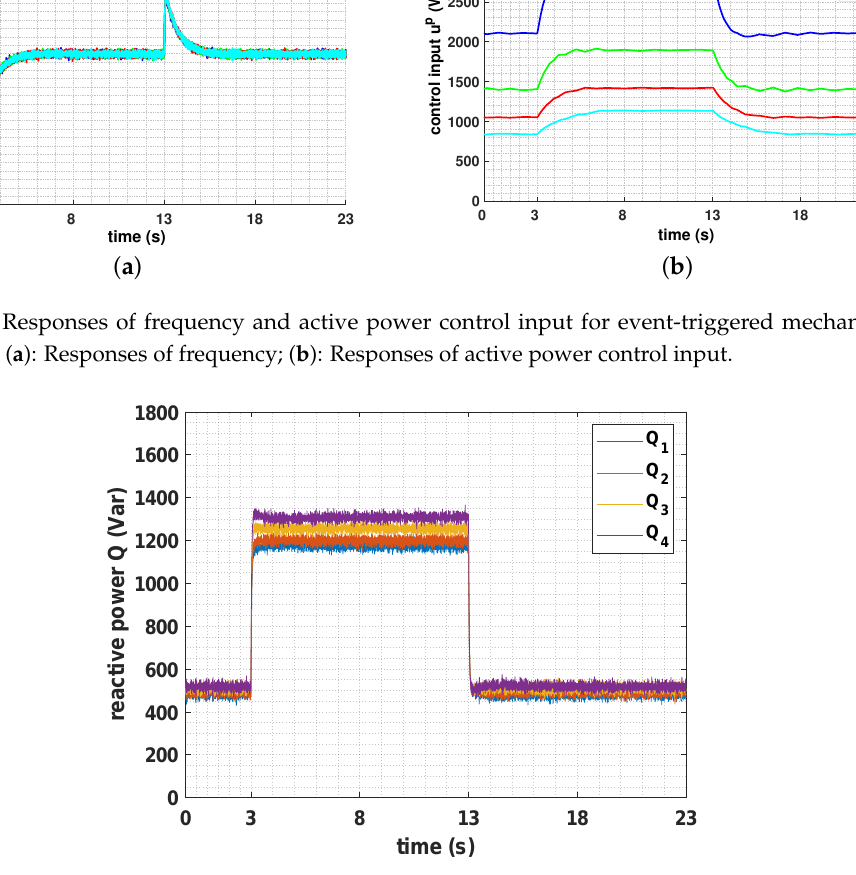
Figure 6. Response of reactive power for event-triggered mechanism in Case A.